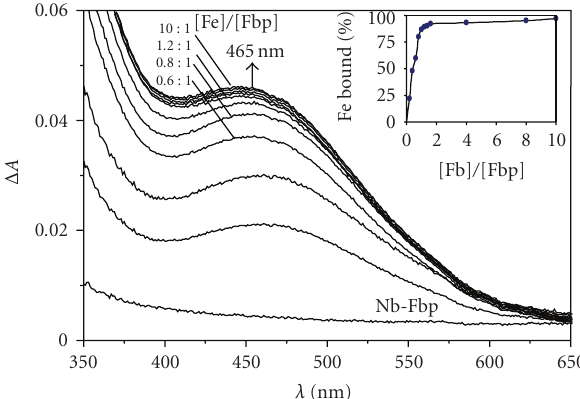
Figure 5: Displacement of Nb V from Nb 2 -Fbp (prepared by incubating apoFbp (100 μ M) with 10mol equiv 1:2 Nb: NTA under the same conditions as Figure 2(a)) by 1 : 2 Fe:NTA in the same bu ff er at 310 K. the band at ca.465 nm increases in intensity with the addition of Fe III . Molar ratios r [Fe] / [Fbp] from bottom to top: are 0, 0.2, 0.4, 0.6, 0.8, 1.0, 1.2, 1.4, 1.6, 4, 8, and 10. Insert shows variation in percentage of Fe III bound to the protein calculated from the LMCT band at 465 nm with the amount of added Fe III